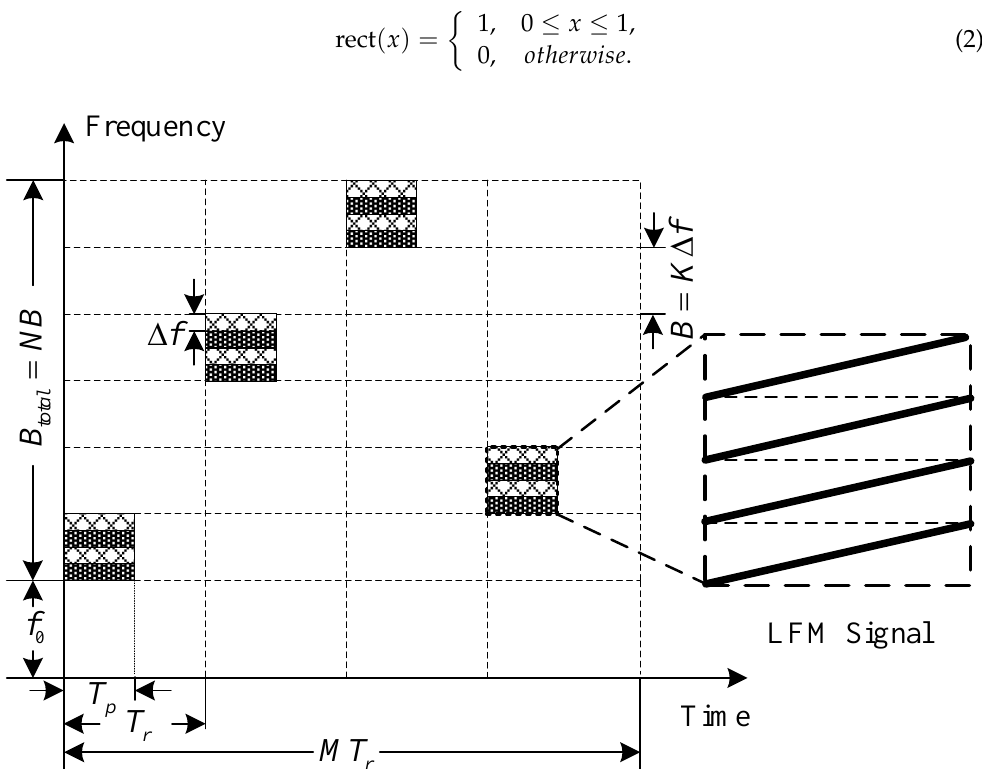
Figure 1. SFA-OFDM radar signal model in the time–frequency